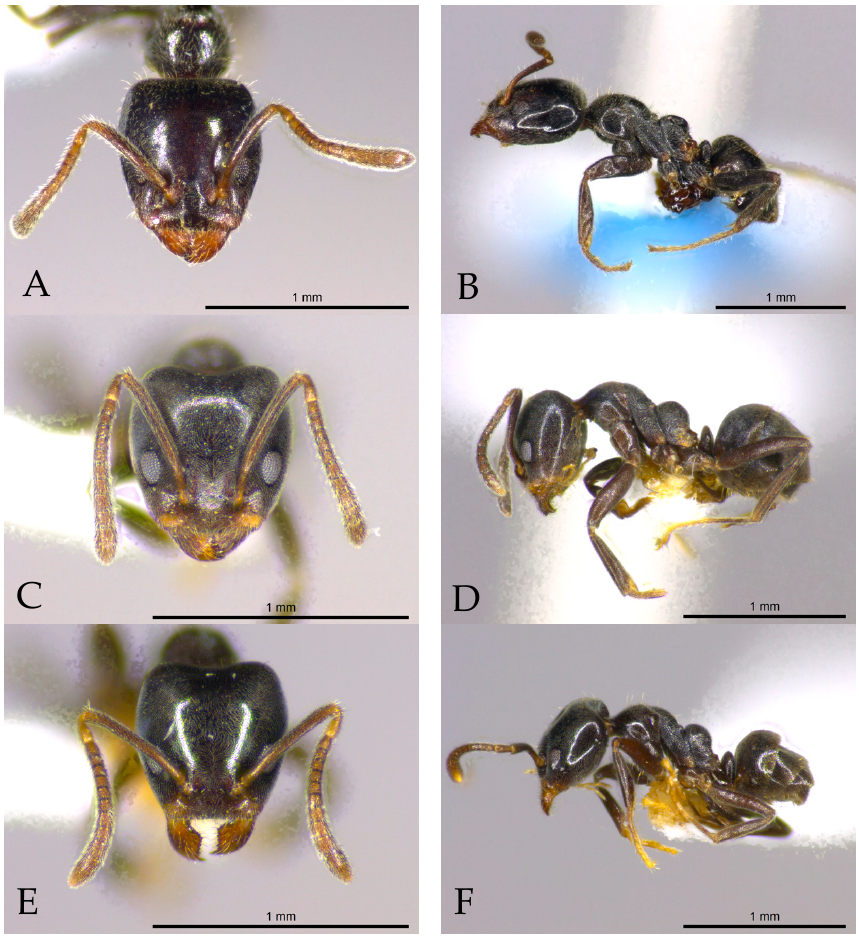
Figure 5. Head and lateral views of Anonychomyrma sp. H ( A , B ), sp. G ( C , D ), and sp. J ( E , F ).